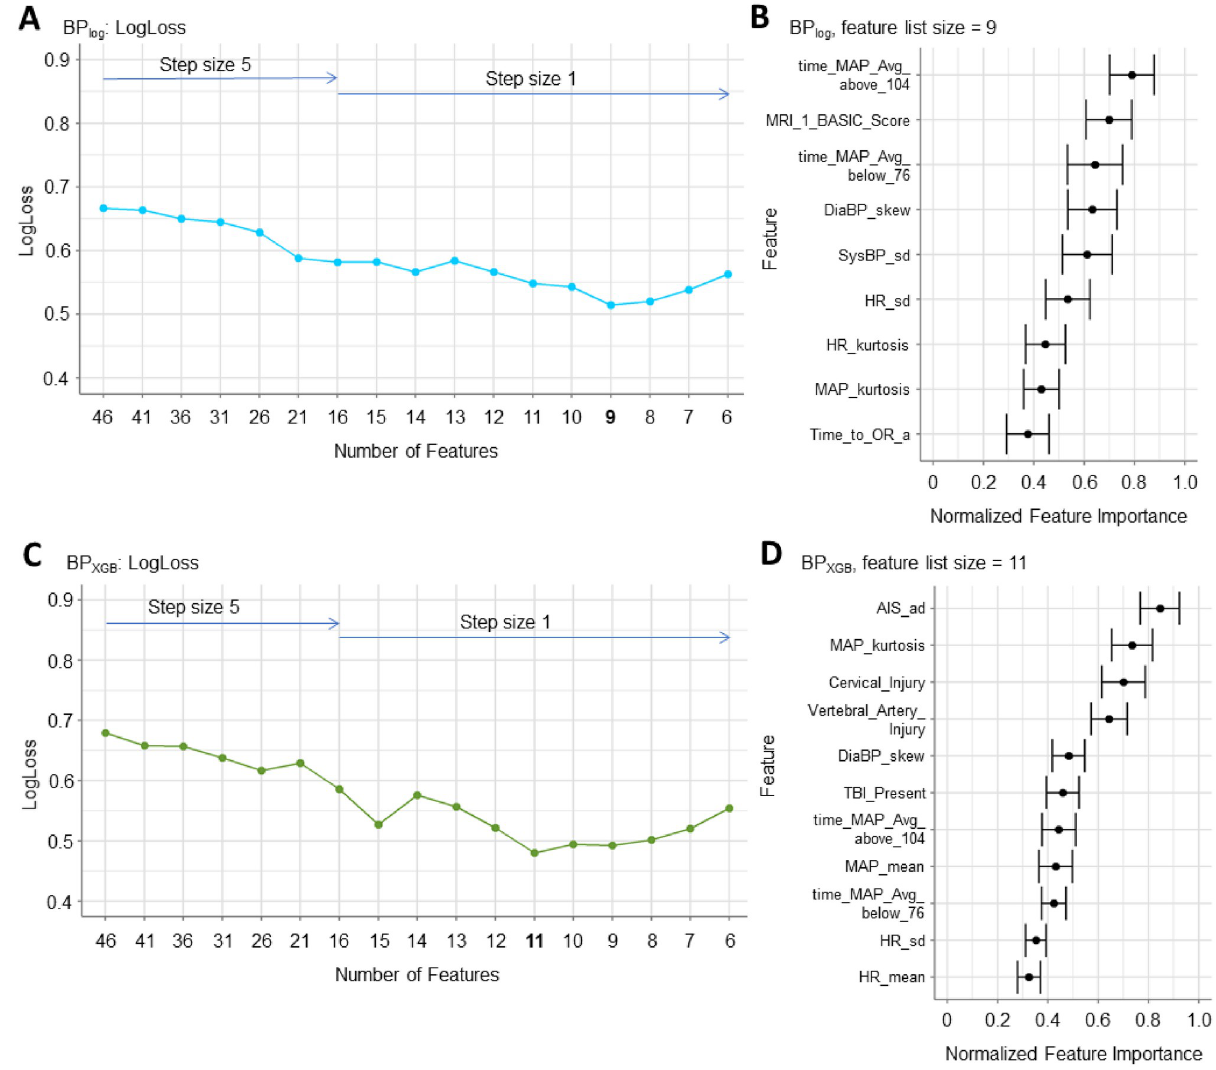
Fig 4. Applying an iterative backward feature reduction process to identify parsimonious feature lists that maximize model performance. The process was performed first by removing the lowest five features by feature importance (step size = 5) and then repeated with step size = 1 within the feature list size range that contained the best performance. (A) For BP log , the step size was reduced starting at 16 features with the best performance observed with the 9-feature parsimonious feature list (LogLoss = 0.55 ± 0.02). (B) The corresponding pFI of the 9-feature parsimonious BP log model showed that the MRI BASIC score and the time patients spent outside of the MAP thresholds were the most important features. The remaining features included other intraoperative timeseries-derived features and the time between hospitalization and surgery ( Time_to_OR_a ). (C) The feature reduction for BP XGB was expanded to always preserve the two MAP threshold features. The step size was reduced to one starting at 16 features with the best performance observed with the 11-feature parsimonious feature list (LogLoss = 0.48 ± 0.02). (D) The corresponding pFI for the parsimonious BP XGB model showed that the AIS score at admission ( AIS_ad ) was the most important feature. Non-timeseries-derived features included Cervical_Injury